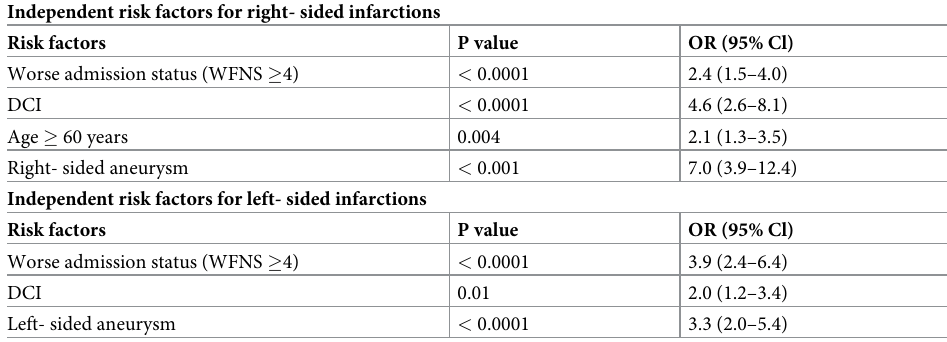
Table 3. Independent risk factors influencing the occurrence of right- and left- sided infarctions (multivariate analysis). Independent risk factors for right- sided